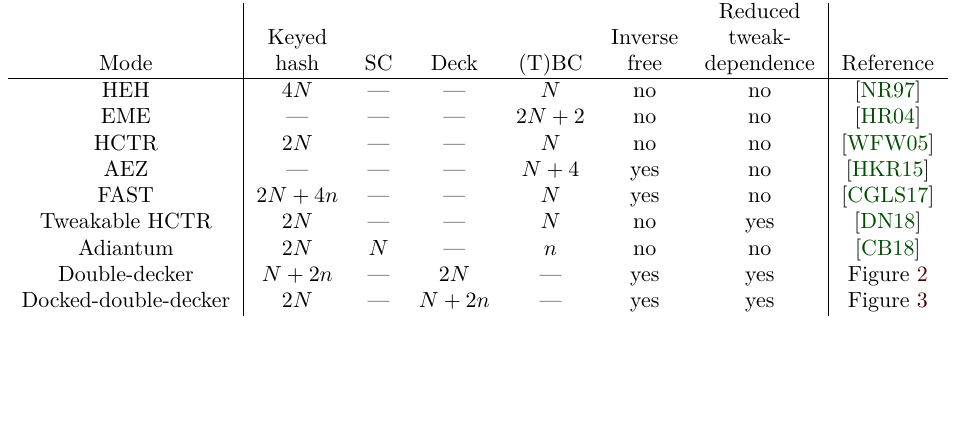
Table 1: Comparison of double-decker and docked-double-decker with state of the art. N is the length of the message, n is a security parameter (i.e., 128 or 256). The cost of keyed hash functions, stream ciphers (SC) and deck functions are displayed as the number of processed bits plus the number of generated bits. The cost of (tweakable) block ciphers ((T)BC) is displayed as only the number of processed bits (or equivalent in the case of AEZ). Refer to Section 1.5 for more information about the properties “Inverse free” and “Reduced